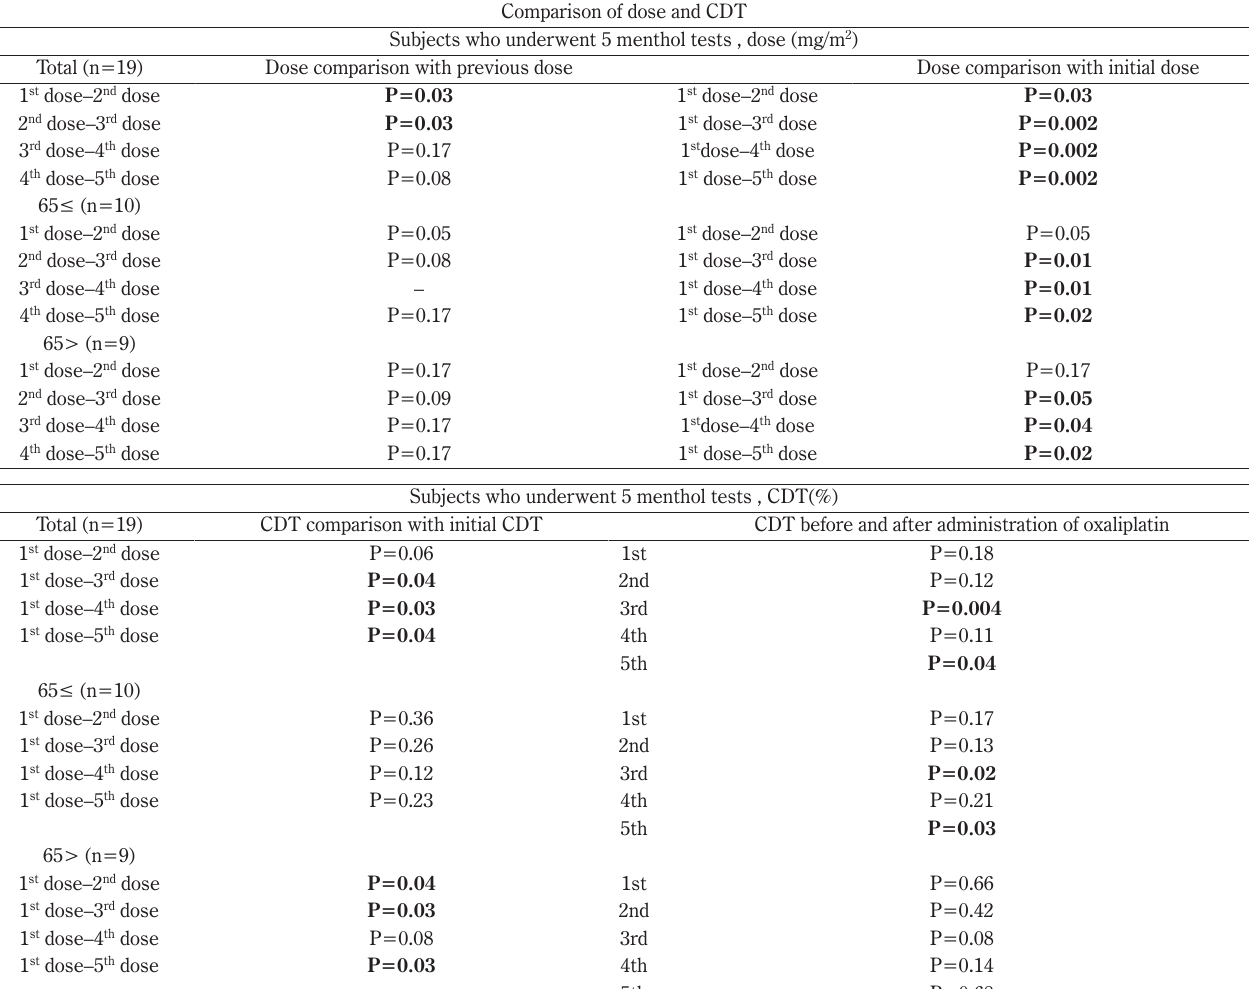
Table 1 Dose and CDT comparison of patients who underwent 5 menthol tests